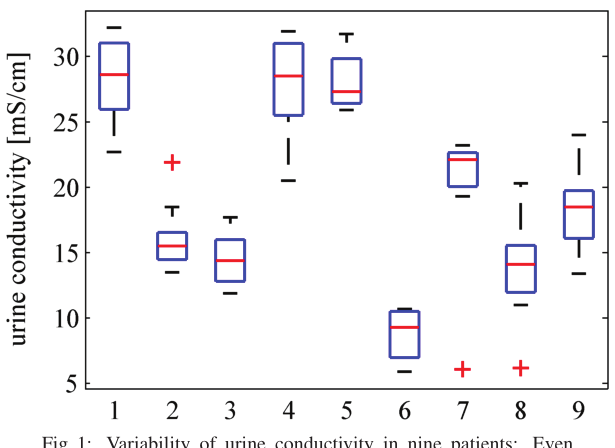
Fig.1: Variability of urine conductivity in nine patients: Even in a hospitalized environment, high intra- and inter-individual variations are